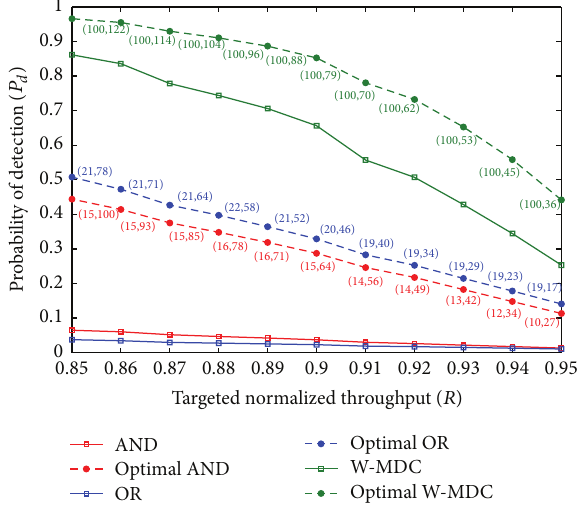
Figure 6: The probability of detection ( 𝑃 𝑑 ) versus targeted normal- ized throughput for AND, OR, and weighted MDC fusion scheme; network with 100SUs and maximum sensing time of 𝜏 max = 100 𝜇 s with ( 𝑘 opt ,𝜏 opt ) are shown in the data tips.